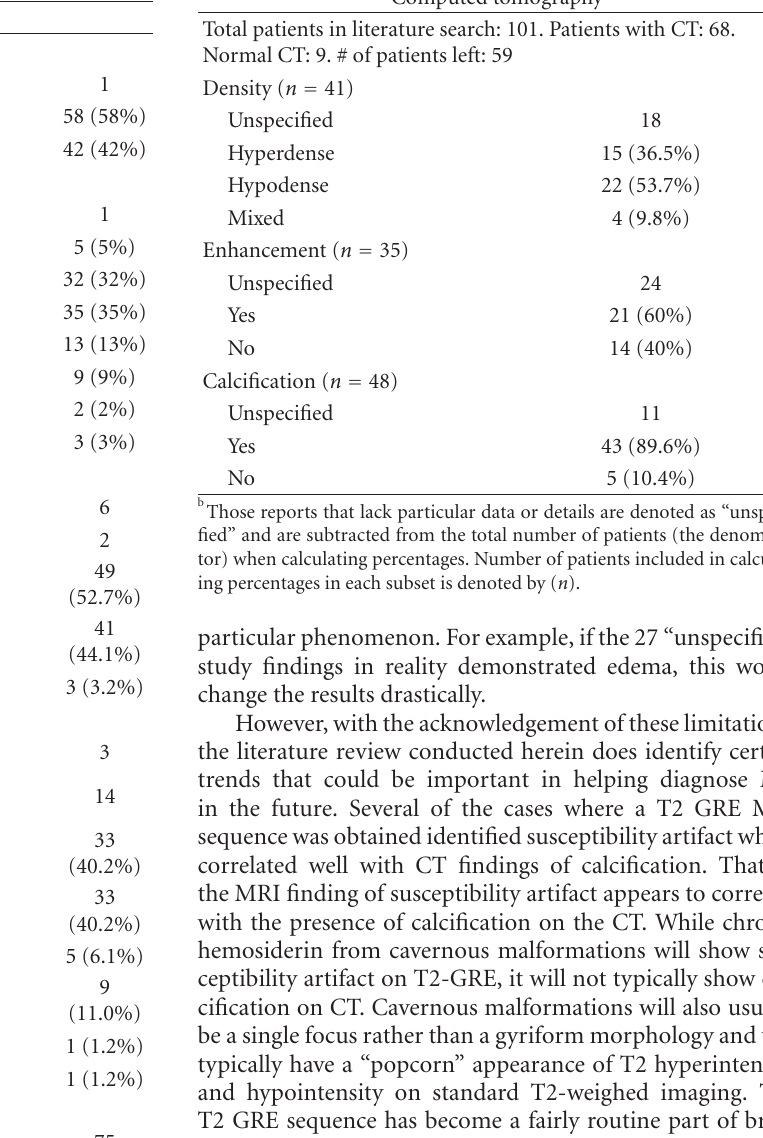
Table 1: Patient characteristics. The below table summarizes the aggregate characteristics of patients appearing in reports that met inclusion criteria for the review of the literature. Total patients in literature review is 101.